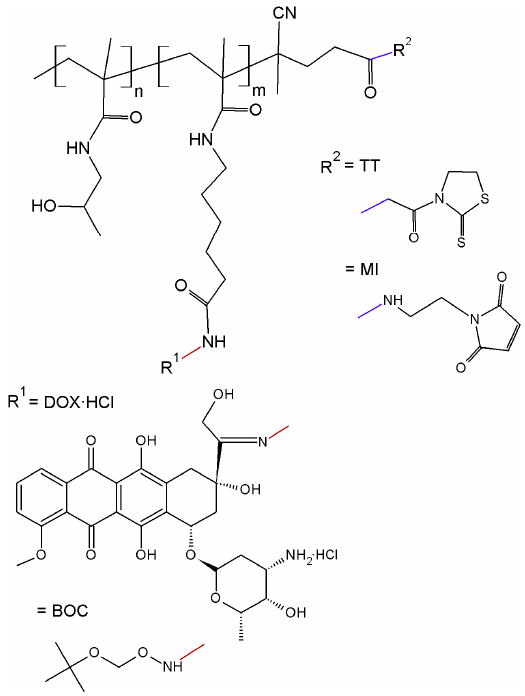
Figure 1. Scheme of semitelechelic polymer precursors used for star-shaped conjugates synthesis: